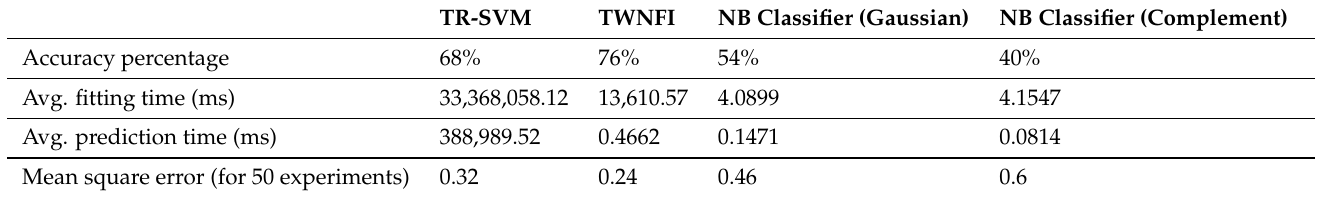
Table 4. Comparison of chosen machine learning algorithms for 2500 samples.